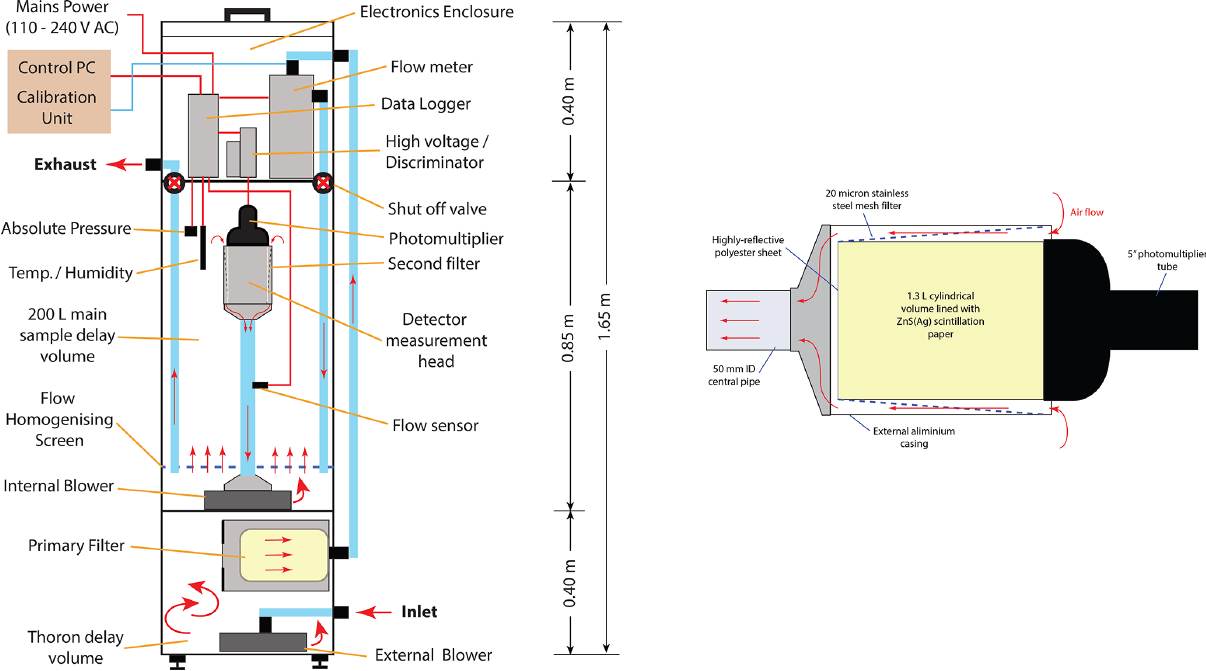
Figure 1. (a) Schematic of the reference monitor, and (b) schematic of the monitor’s radon measurement head.